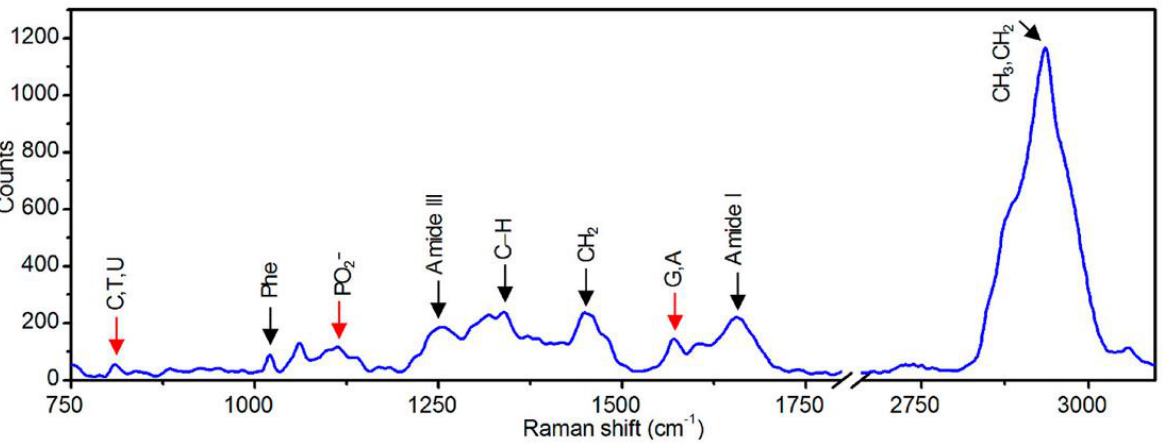
Figure 6. Raman spectrum of S. aureus cells in a panel acquired by suing an excitation power on the sample of up to 2 mW and an acquisition time of up to 30 s, as reported by Li et al. [161]. Picture reproduced with permission from the American Chemical Society (Copyright © 2019, American Chemical Society).